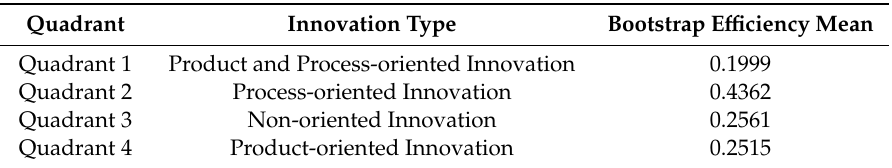
Table 5. Bootstrap DEA